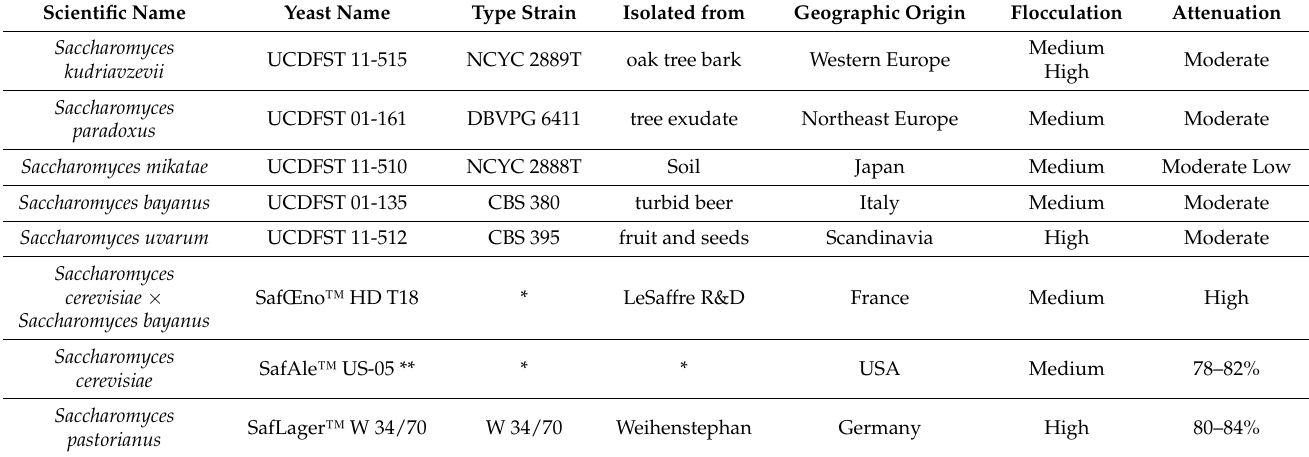
Table 1. Non-conventional non- cerevisiae Saccharomyces and control yeasts used in the fermentations of the experimental beer. Yeasts were sourced from either the Phaff Yeast Culture Collection at the University of California, Davis (UCD), or from Fermentis LeSaffre of Marcq-en-Baroeul, France (Saf). Type strain as defined in MycoBank (mycobank.org), origin, isolation, flocculation, and attenuation, as defined in the scientific or product literature. SafAle™ US-05 and SafLager™ W 34/70 are included as analytical